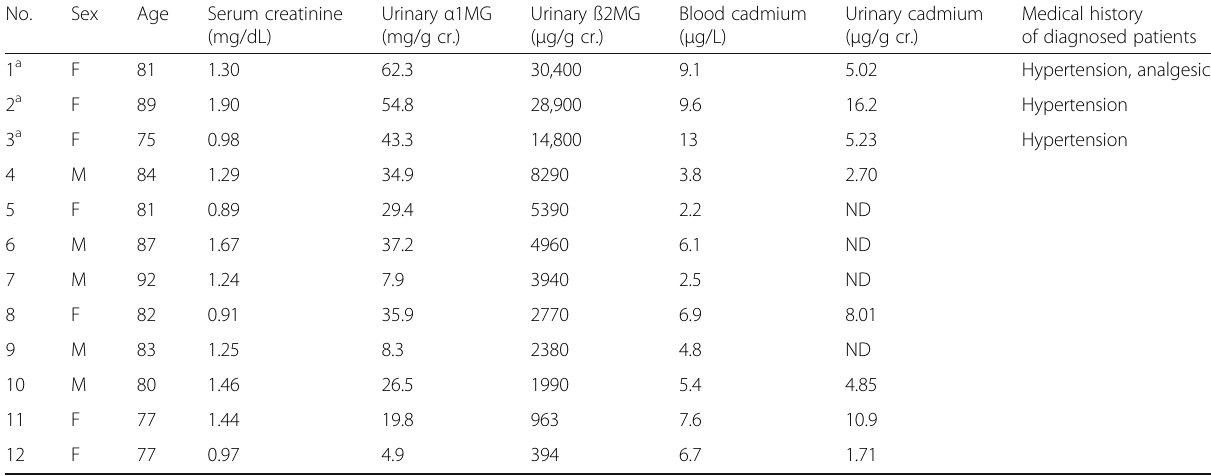
They are listed in order of descending levels of urinary β